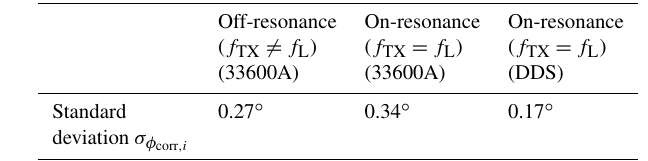
Table 1. Comparison of the phase distribution of the recorded FID signals for the proposed DDS-based frequency generator and com- mercial instruments for 10 consecutive